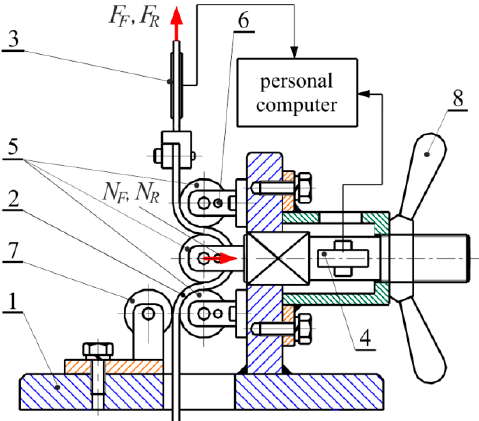
Figure 4. Schematic representation of the measuring device for DBT: 1—Frame; 2—Specimen; 3—Vertical load cell; 4—Horizontal load cell; 5—Working rollers; 6—Blocked pin; 7—Supporting roller; 8—Nut.